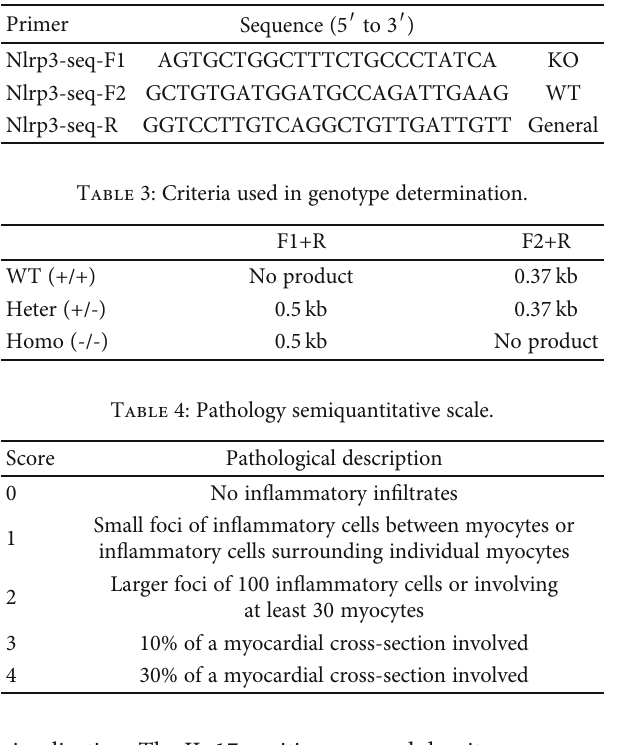
Table 2: Primers used in NLRP3 identi fi cation.